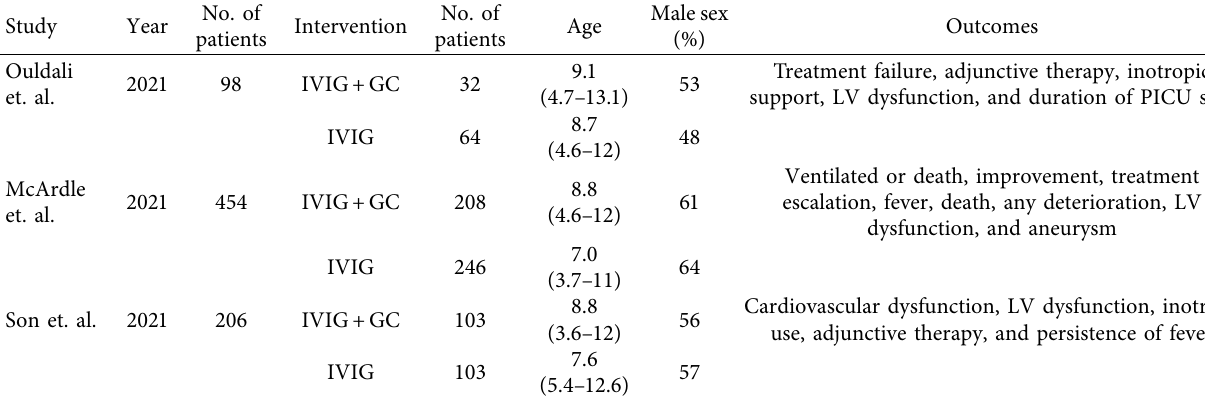
Figure 1: PRISMA flowchart showing selection of studies. Table 1: Baseline characteristics of the included